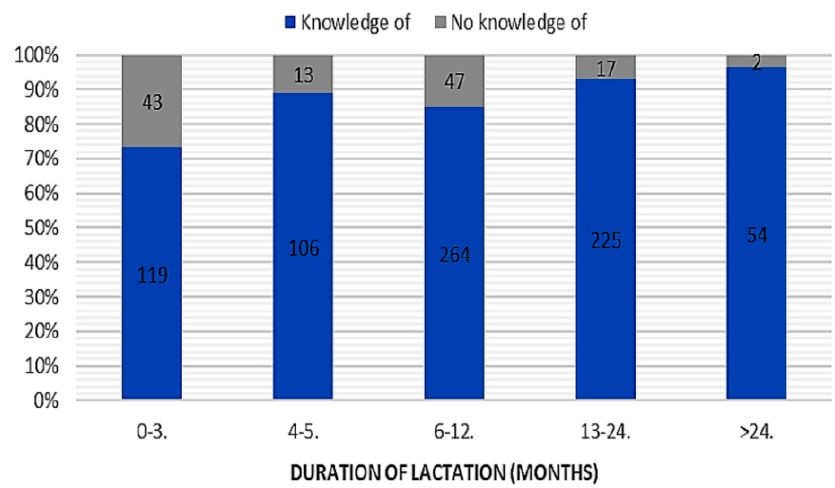
Figure 1. The duration of lactation and “knowledge” of the use of breast milk in prevention and treatment of mucosal ailments (“knowledge of” vs. “no knowledge of”).